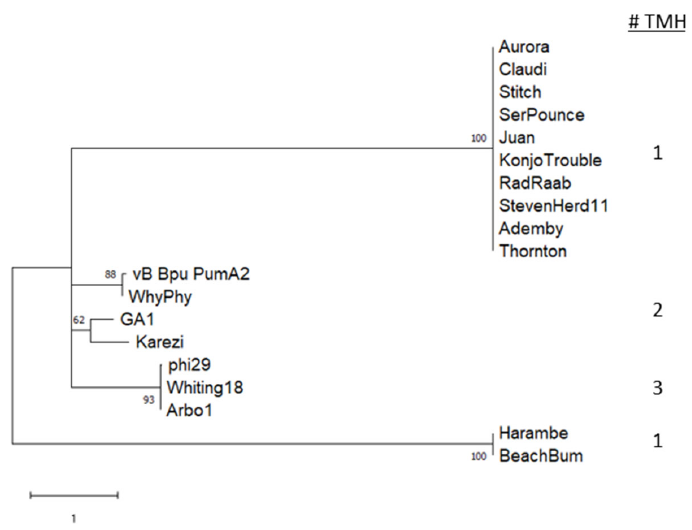
Figure 7. Holin phylogeny. The tree with the highest log likelihood ( − 1616.44) is shown. The tree is drawn to scale, with branch lengths measured in the number of substitutions per site. Bootstrap values indicate the percent of iterations producing replicate clade arrangements after 500 iterations.